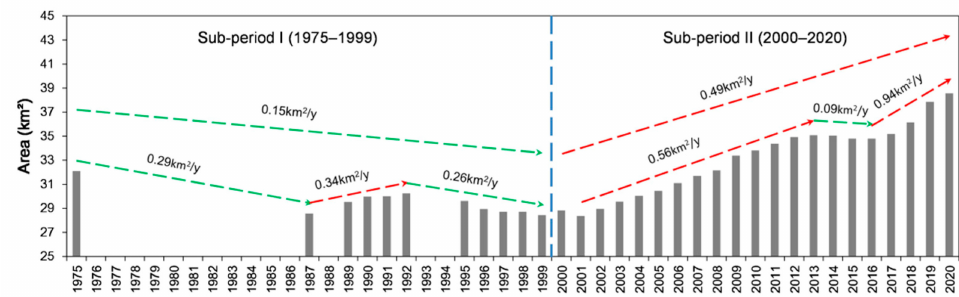
Figure 10. Interannual variation of the area of Gahai